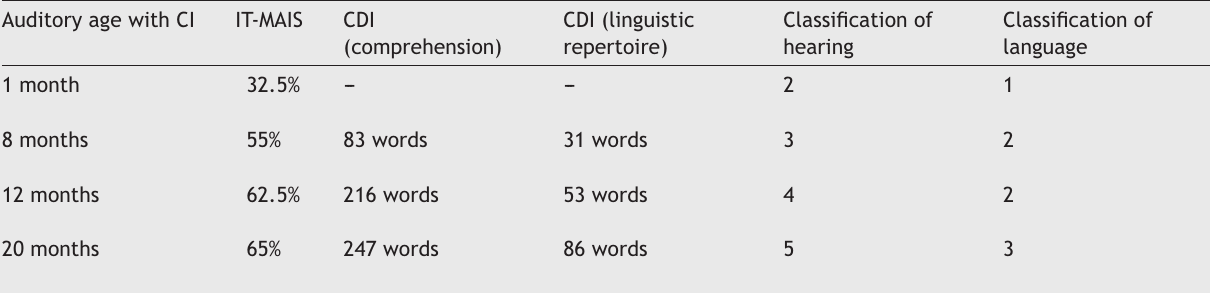
Results of IT-MAIS and CDI tests and classifications of hearing and language of participant B. Auditory age with CI